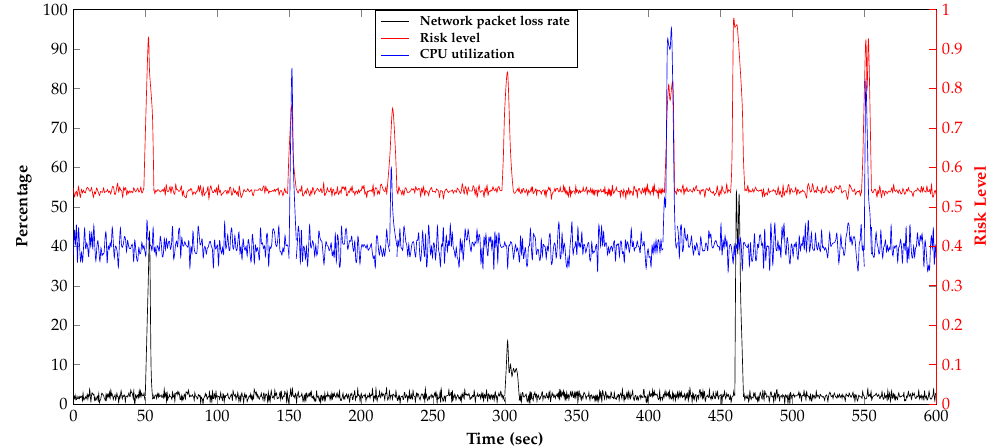
Figure 5. The relationship between the risk value of virtual machine M 2 and the